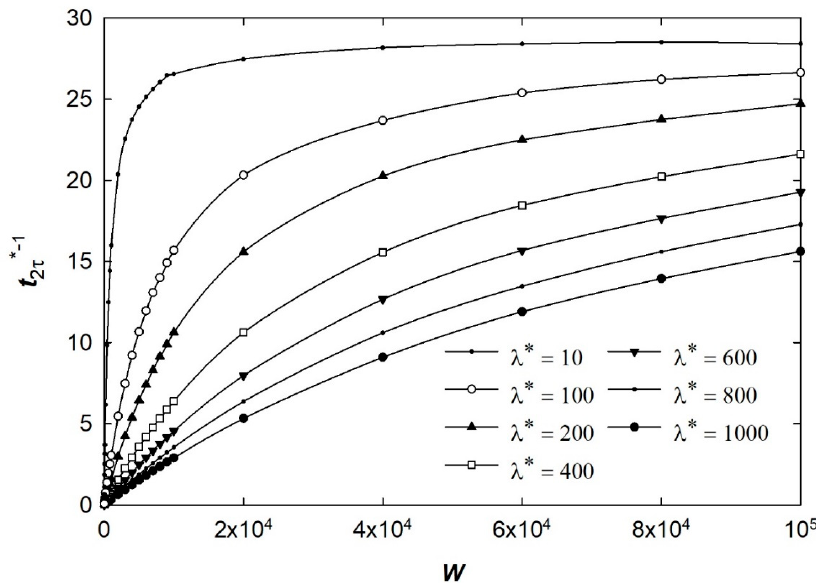
Figure 10. Reciprocal dimensionless time at two times characteristic time τ of the process at x * = 0.75 versus dimensionless anchoring energy for different ranges of surface viscosity.